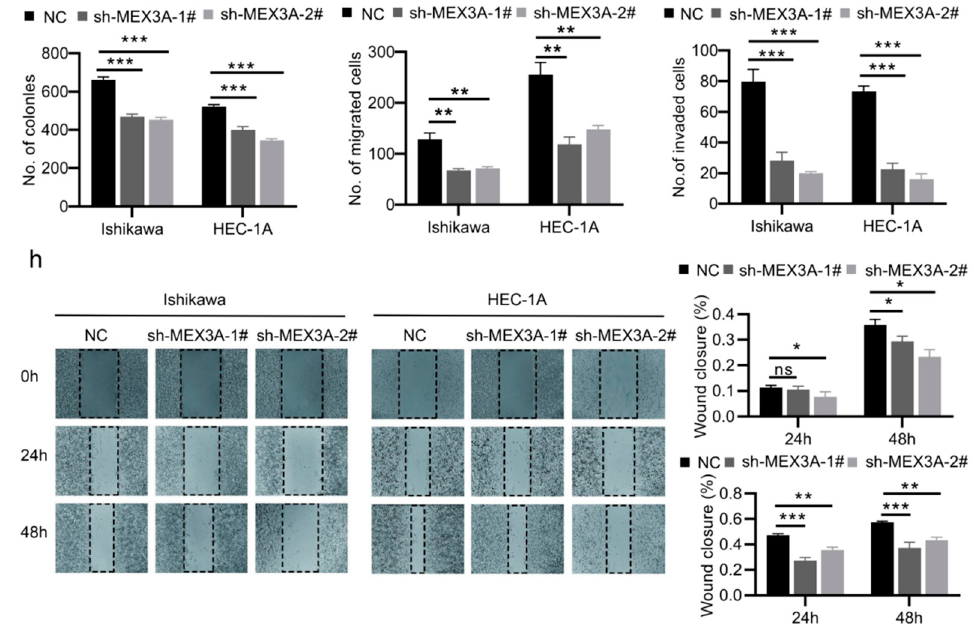
Figure 2. MEX3A promotes the proliferation and metastasis of EC cells in vitro. ( a , b ) mRNA and protein levels of MEX3A in five EC cell lines. ( c , d ) The efficacy of MEX3A knockdown in Ishikawa and HEC-1A cells measured through qRT-PCR and Western blotting. ( e , f ) CCK-8 and colony-formation assays (200×) showing that the MEX3A knockdown damaged the proliferation of Ishikawa and HEC-1A cells. ( g , h ) The migration and invasion abilities of Ishikawa and HEC-1A cells were impaired after the knockdown of MEX3A, as shown by the transwell and wound-healing assays (200×). * p < 0.05, ** p < 0.01, *** p < 0.001.